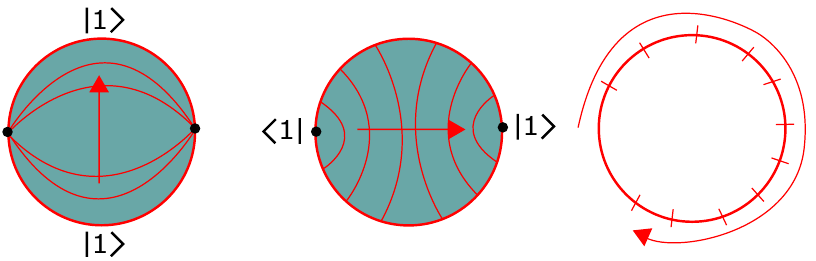
Figure 3 . Left: disk amplitude in the open channel. Middle: disk amplitude in the crossed channel. Right: boundary circle with evolution along the